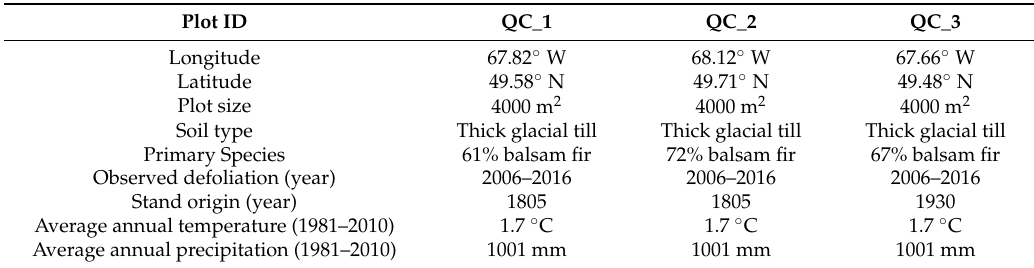
Table 1. Stand location, soil type, and observed defoliation of the balsam fir study sites in the North Shore region of Qu é bec,